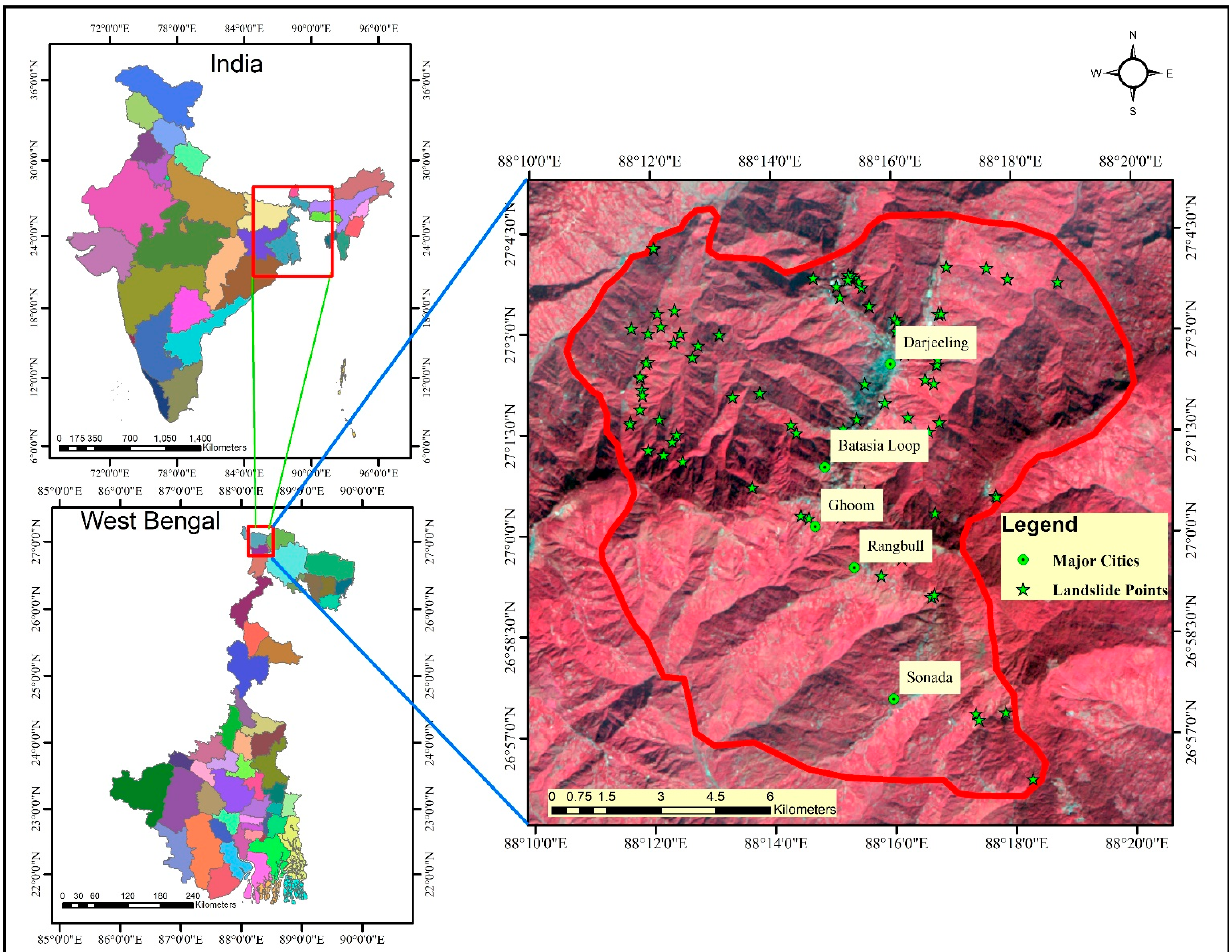
Figure 1. Location of the study area.